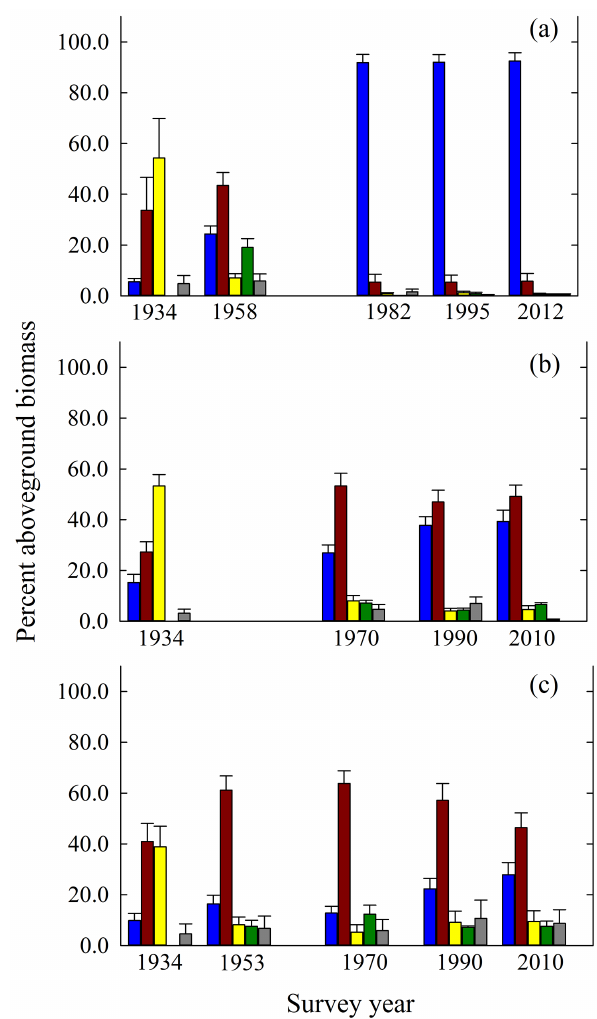
Figure 3. Percentage ( ± SE bars) of aboveground biomass for the xylem functional groups (diffuse-porous, ring-porous, semi-ring porous, tracheid, and evergreen shrub) in the (a) treated WS6, (b) reference WS14, and (c) reference WS18 over time.